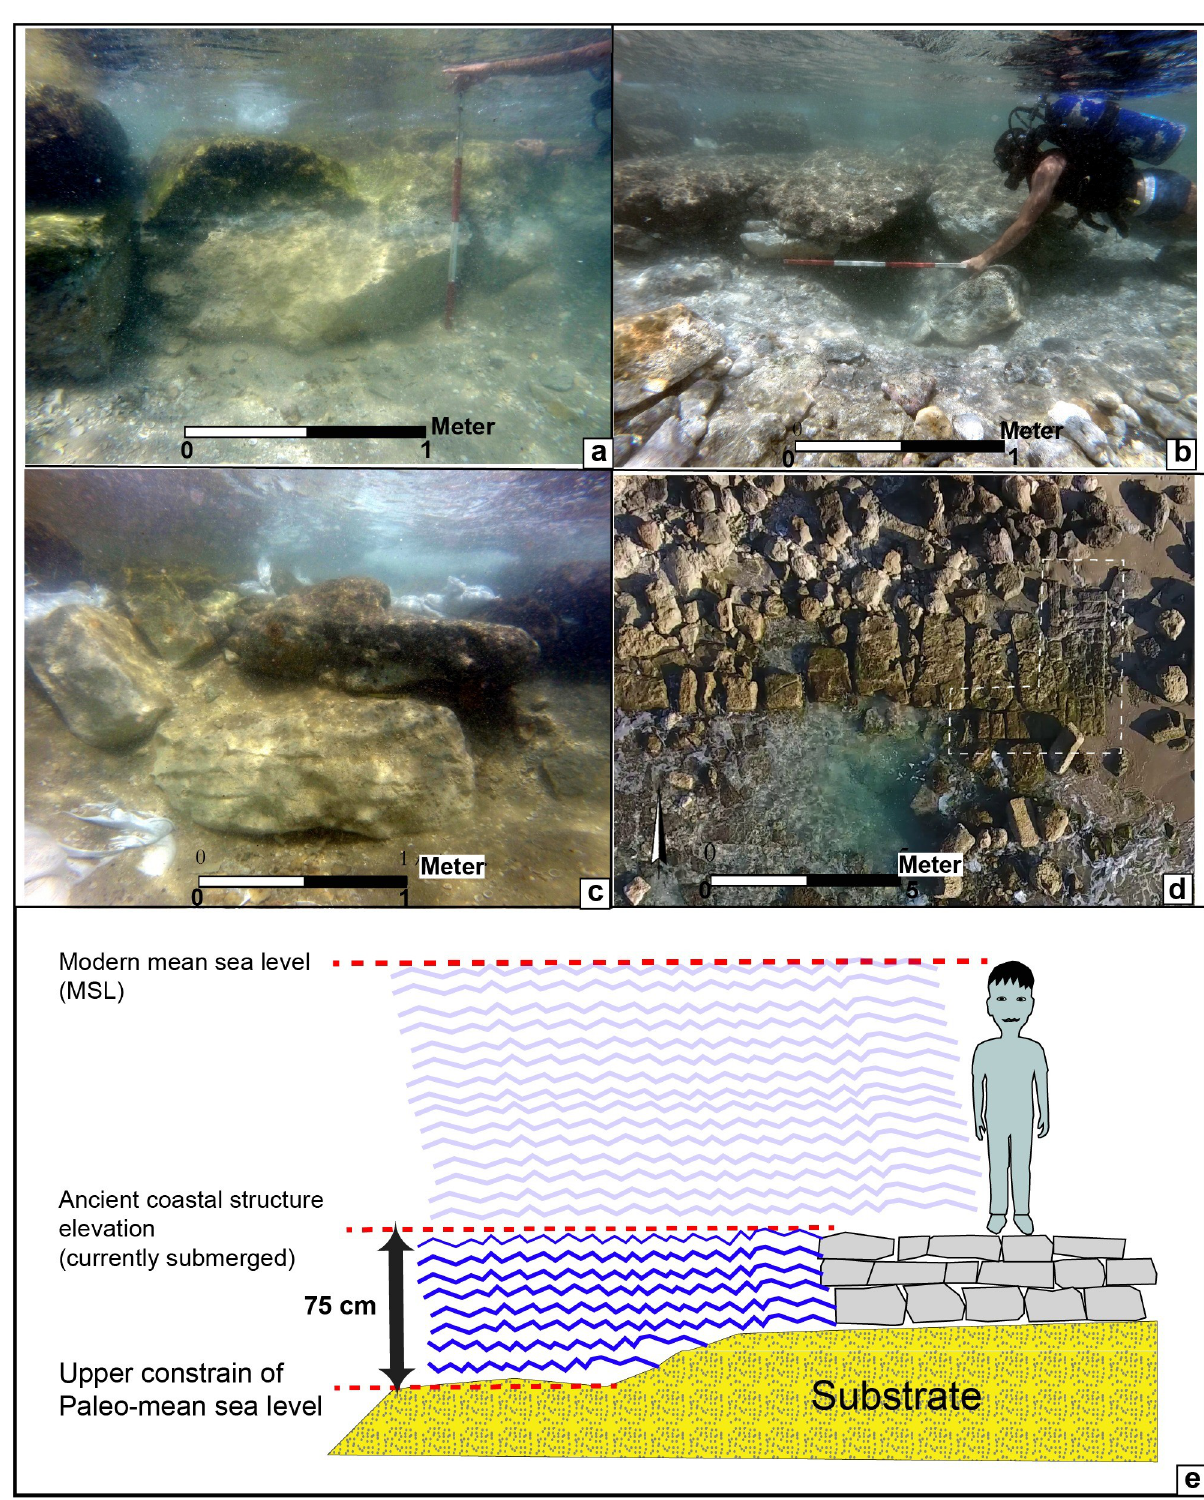
Fig 2. Selected examples of the new archaeological constructions used in the current study for establishing RSL; (a) Dor 8—the base of a terrestrial massive fortification wall (W16S-220); (b) Dor 10—base of a terrestrial massive fortification wall (W16S-210); (c) Dor 7—base of a terrestrial wall (W16S-240) (d) Dor 18 –floor level of passage in Assyrian sea gate (W16S-230); (e) an illustration showing the relationship between the coastal archaeological construction and its use for establishing the relative mean sea level.